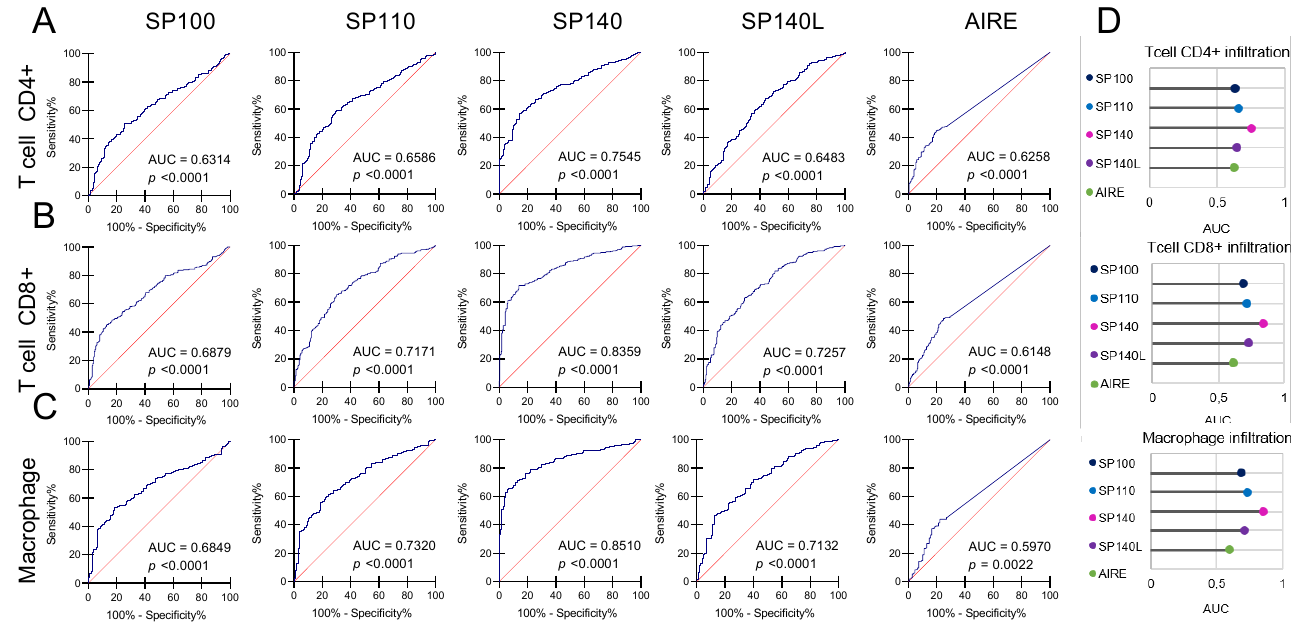
Figure 4. Survival prognosis based on immune-cell infiltration for SP family ( SP100 , SP110 , SP140 , and SP140L ) and control ( AIRE ) gene in SKCM. The ROC curves show the prognostic significance of SP family members and control genes related to the infiltration of relevant immune cell populations: T cell CD4+ ( A ), T cell CD8+ ( B ), and macrophage ( C ). The area under the curve (AUC) was calculated for the ROC curve. ( D ) The AUCs for SP140 exhibit the highest values for all tested immune cell populations in SKCM. The results for ATAD2 control genes are not shown due to lack of statistical significance ( p > 0.05).